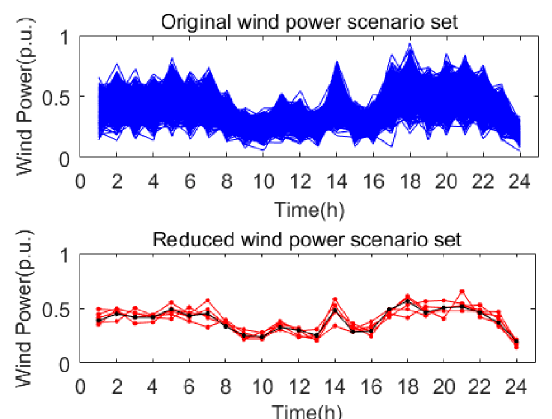
Figure 3. The original and reduced wind power scenario sets.